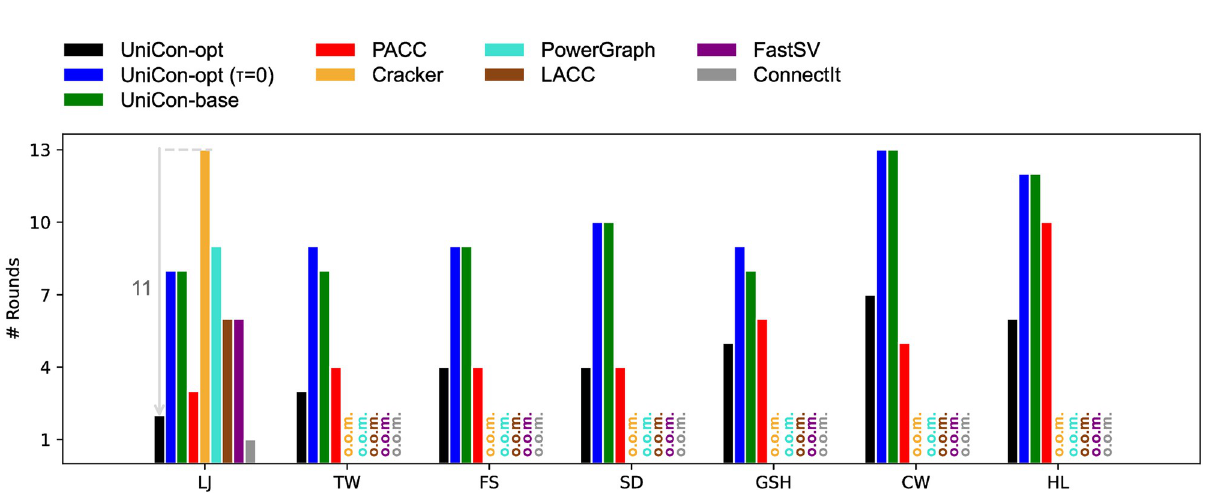
Fig 16. The numbers of rounds required by all algorithms except Rem on real-world graphs. UniCon-opt requires up to 11 fewer rounds than